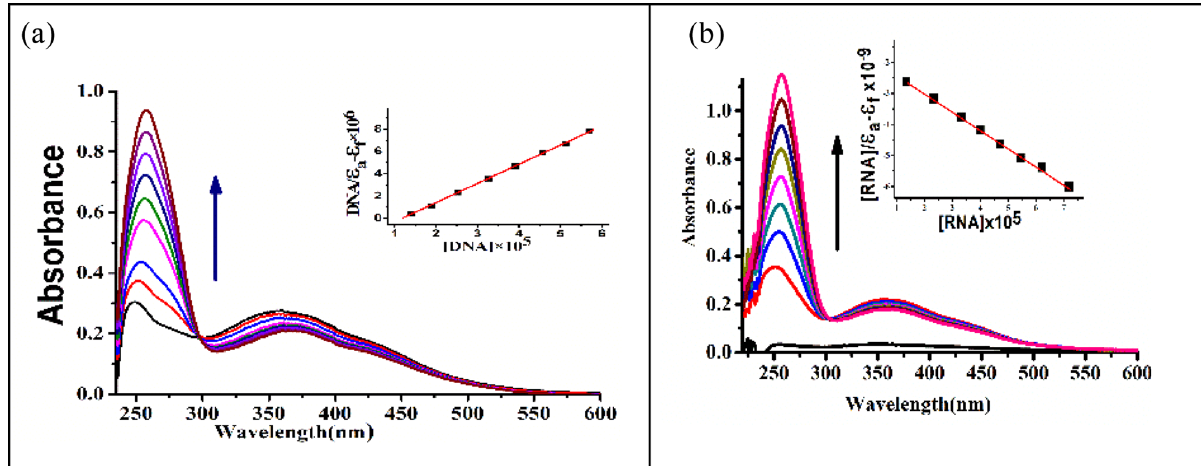
Figure 4: UV - Vis spectra of ( a ) 1 - ct - DNA ( b ) 2 - t - RNA with constant increasing concentration of ct - DNA and t - RNA ( 0 – 125 mL ) at 298